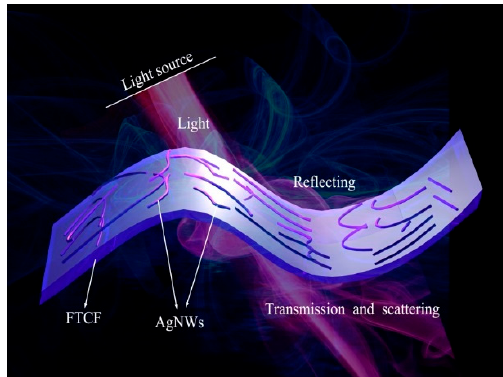
Figure 2. Interaction between light and AgNWs-based FTCF.